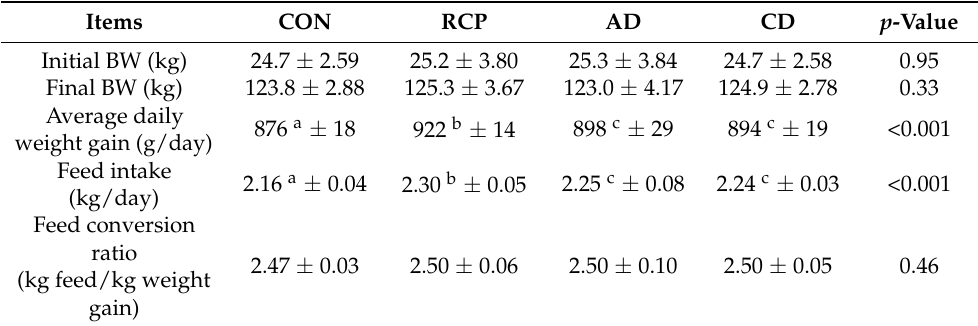
Table 3. Effects of experimental diets on average daily feed intake, average daily weight gain and feed conversion ratio (mean ± standard deviation, n = 12).